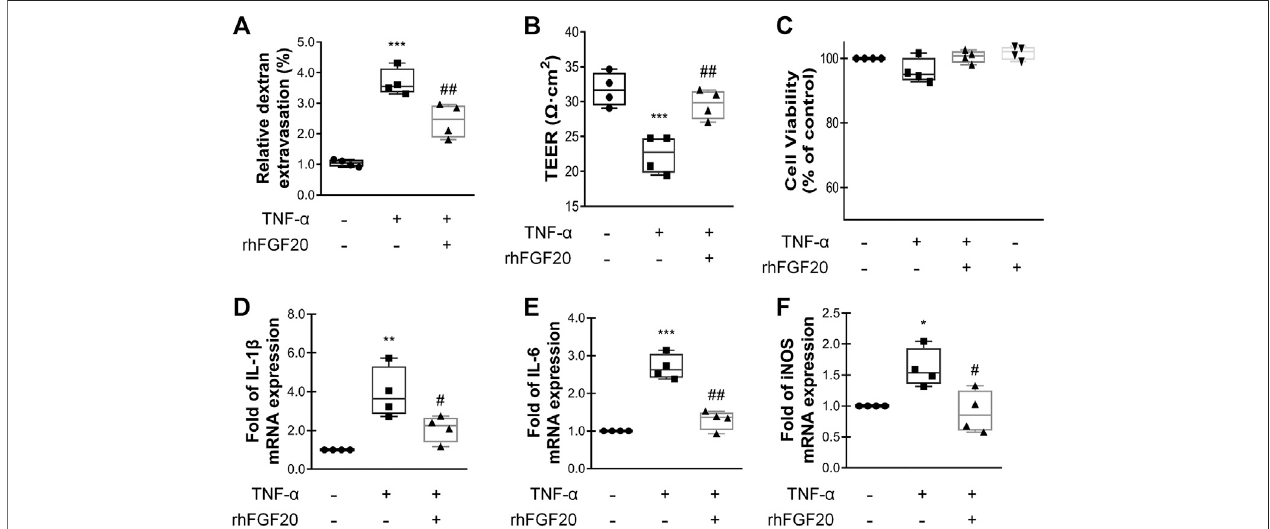
FIGURE 6 | rhFGF20 protected against TNF- α -induced BBB injury (A) Effects of rhFGF20 in the HBMECs FITC-dextran permeability test ( n (cid:1) 4) (B) Effects of rhFGF20 on TEER measurements ( n (cid:1) 4) (C) Effects of TNF- α and rhFGF20 on HBMEC viability ( n (cid:1) 4) (D – F) Effects of rhFGF20 on the mRNA levels of the proin fl ammatory cytokines IL-1 β , IL-6, and proin fl ammatory enzyme iNOS; levels were normalized to those of the housekeeping gene β -actin ( n (cid:1) 4). ** p < 0.01, *** p < 0.001 vs. the control group. # p < 0.05, ## p < 0.01 vs. the TNF- α group. Data are presented as the mean values ± SD.